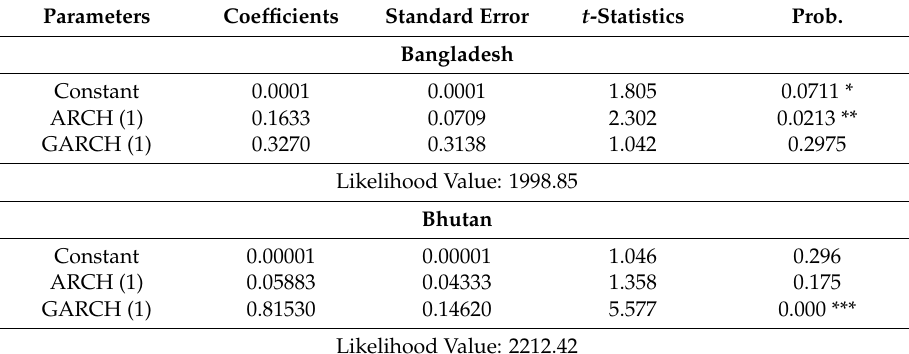
Table A4. Estimation of Parameters in GARCH (1,1) Model for Exchange Rate